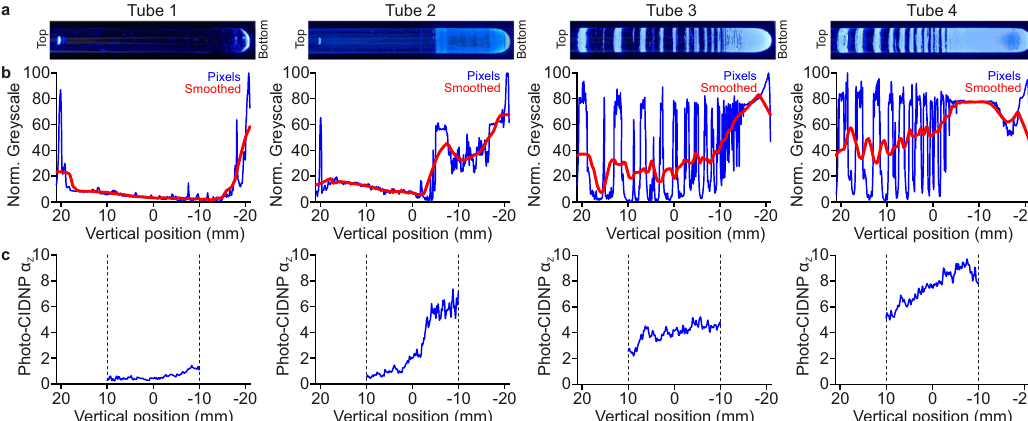
Fig. 3 Effect of tube etching patterns on light distribution in NMRtorch sample tubes along the Z -axis. Tube 1 — unetched; Tube 2 — only bottom portion etched; Tubes 3 and 4 — etched in a similar pattern, with tube 4 etched more than tube 3. a Photo images of example tubes illuminated with attenuated 460 nm light to avoid detector saturation. b Pixel brightness analysis of tube images, with pixel greyscale values normalised between lowest and highest values for each image as a measure of scattered light intensity. Smoothed values calculated using moving averages over ±2.5 mm. The tubes in a and b were fi lled with H 2 O to a depth of 40 mm from tube bottom. c NMR assessment of light distribution based on position-dependent photo-CIDNP enhancement ( α ) of 6 mM 6FI + 0.2 mM FMN in NMR imaging experiments with 6 s illumination times. Dashed vertical lines indicate the extent of the Z NMR-detectable volume. Vertical position measured along the Z -axis of the sample (here, horizontal), relative to the centre of the NMR coil, with the positive numbers towards the top of the